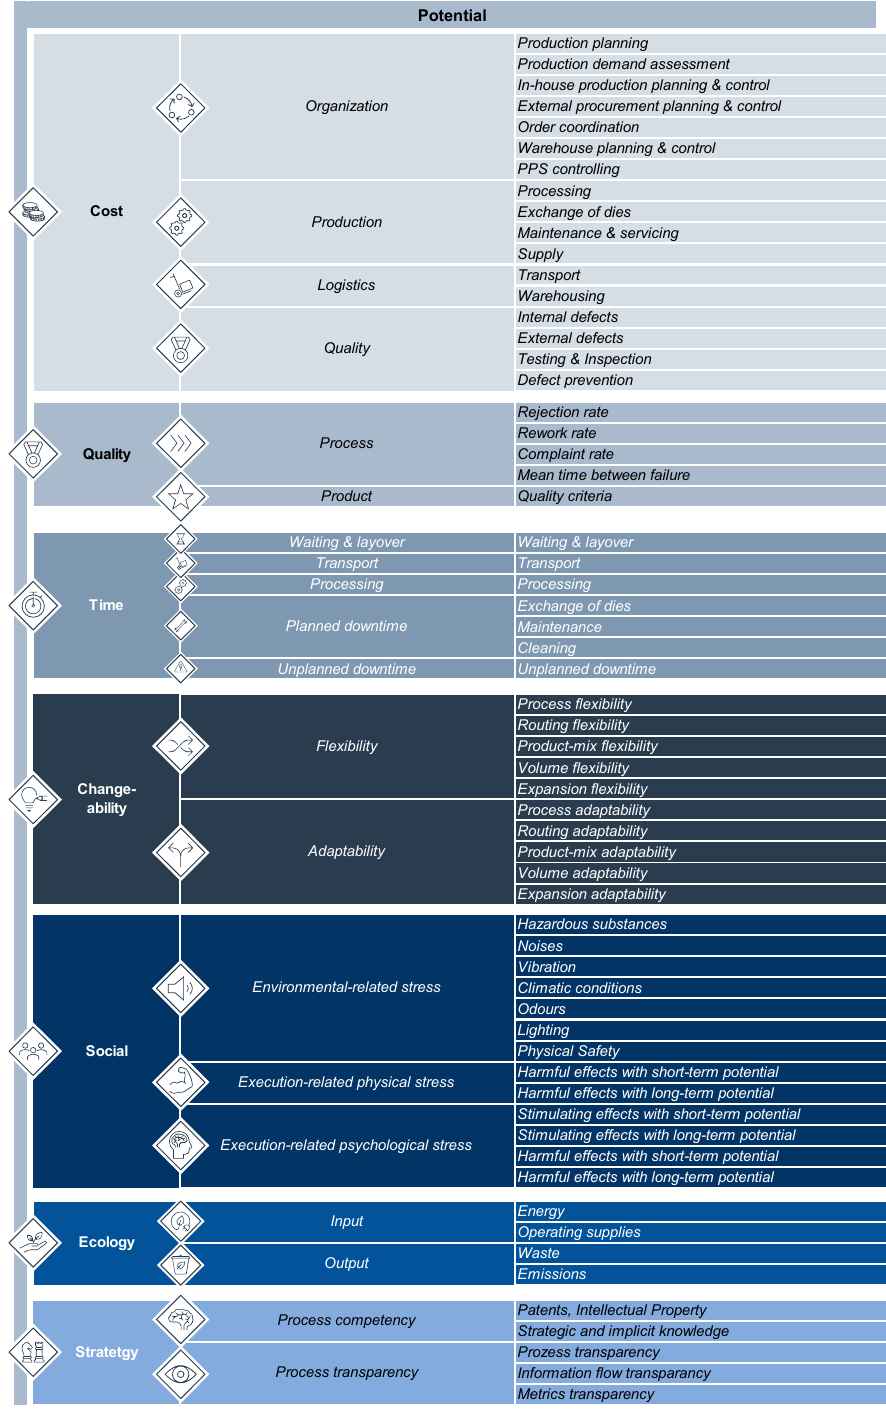
Figure 4. Relevant criteria to assess the potential of an innovation project in manufacturing.